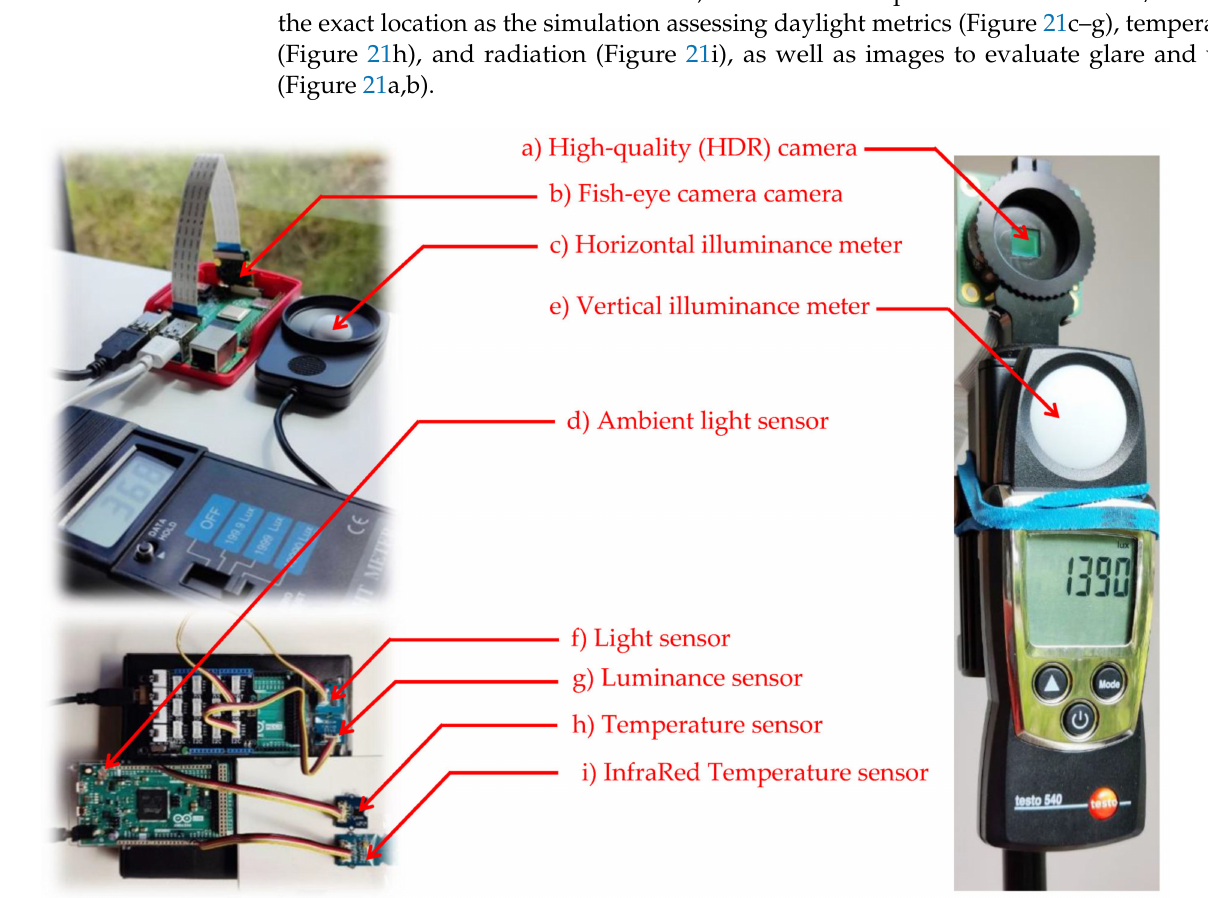
Figure 21. Field measurement validating the simulation results. The measurements were performed on a network that conforms to the sensors placed in the simulation. Illuminance meters and light sensors feed the sDA, ASE, UDI, and DF analysis; cameras provide images to analyze DGP and view to the